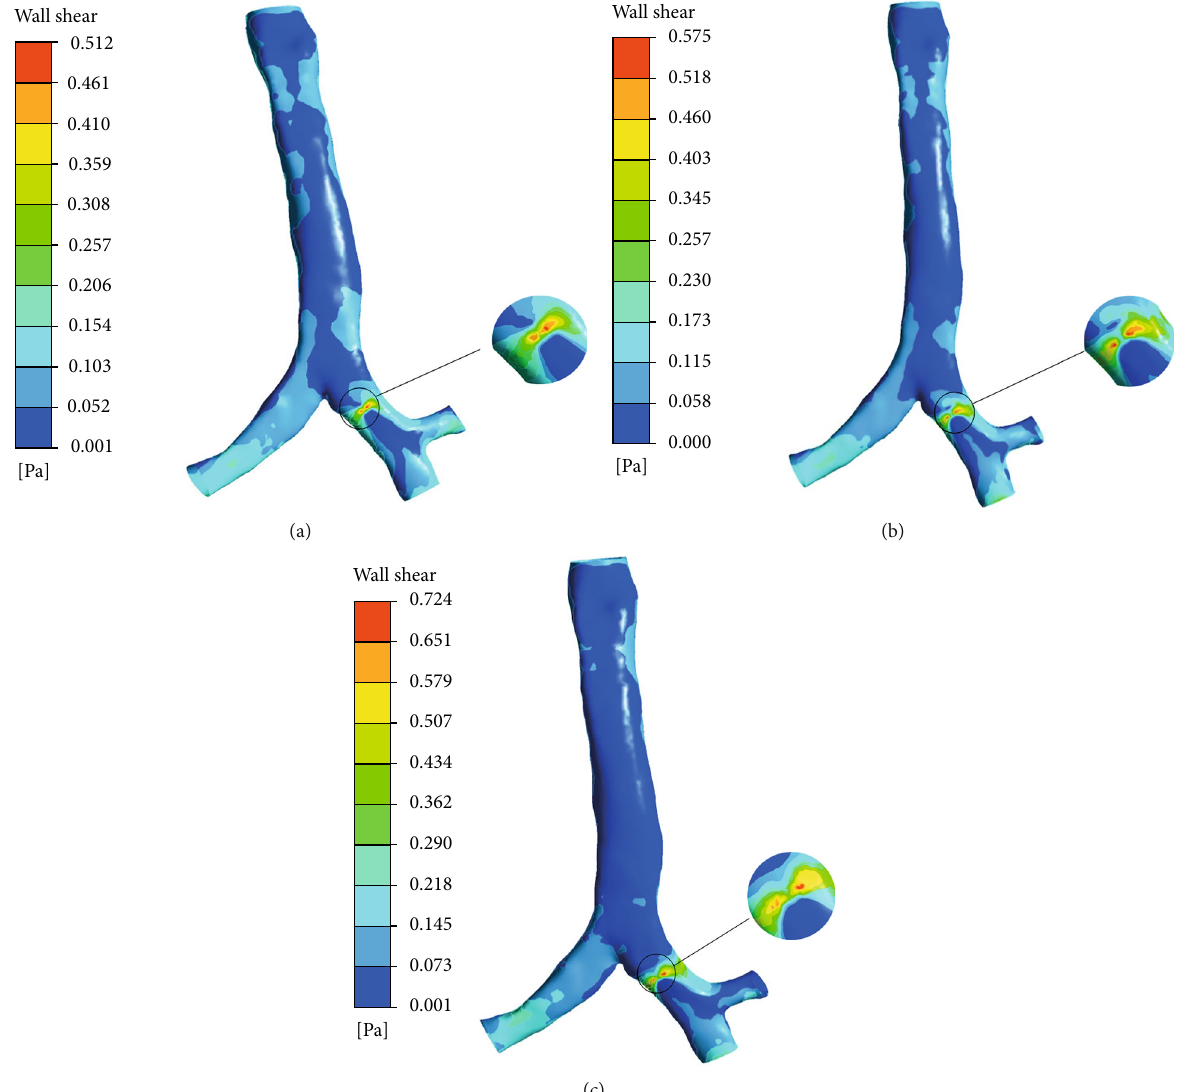
Figure 11: Wall shear for the three lung models at 2.1326m/s: (a) 6 mm foreign body, (b) 8 mm foreign body, (c) 10mm foreign